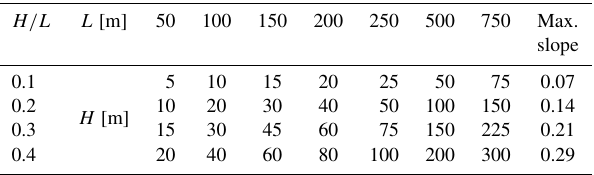
Figure 1. Exemplary sketch of a Gaussian hill used in the parameter study. Each hill is defined by its height H and its hill half-width L . A representation of the lidar geometry for measurement height z and a half-cone opening angle ϕ is shown as well. In this example, H is 100m, and L is 250m, resulting in an H/L ratio of 0.4 and for the measurement height z of 150m in a z/L ratio of 0.60. Table 1. Set of Gaussian hill geometries used in the parameter study. The table provides information about the hill height H , the hill half-width L , and the corresponding ratio H/L . Additionally the maximum slope (maximum terrain inclination) at the flanks of the hill is calculated for the four different used